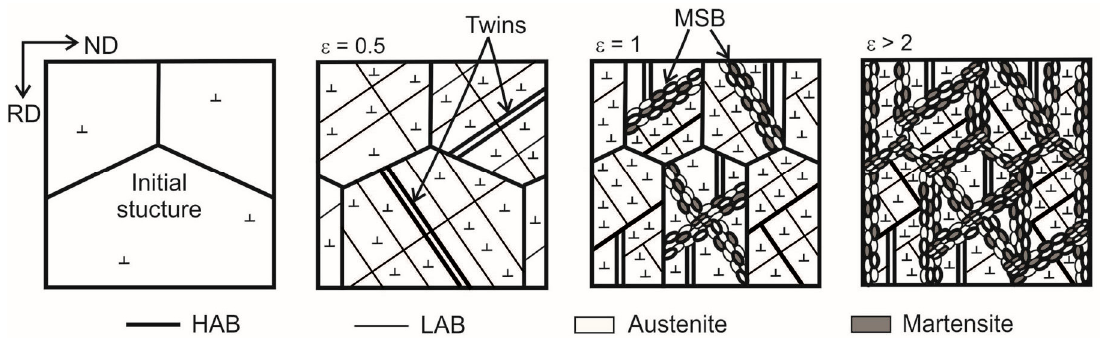
Figure 11. Schematic representation of the structural changes in austenitic stainless steels during rolling at 473 K. MSB—microshear bands, HAB—high-angle boundaries and LAB—low-angle boundaries.